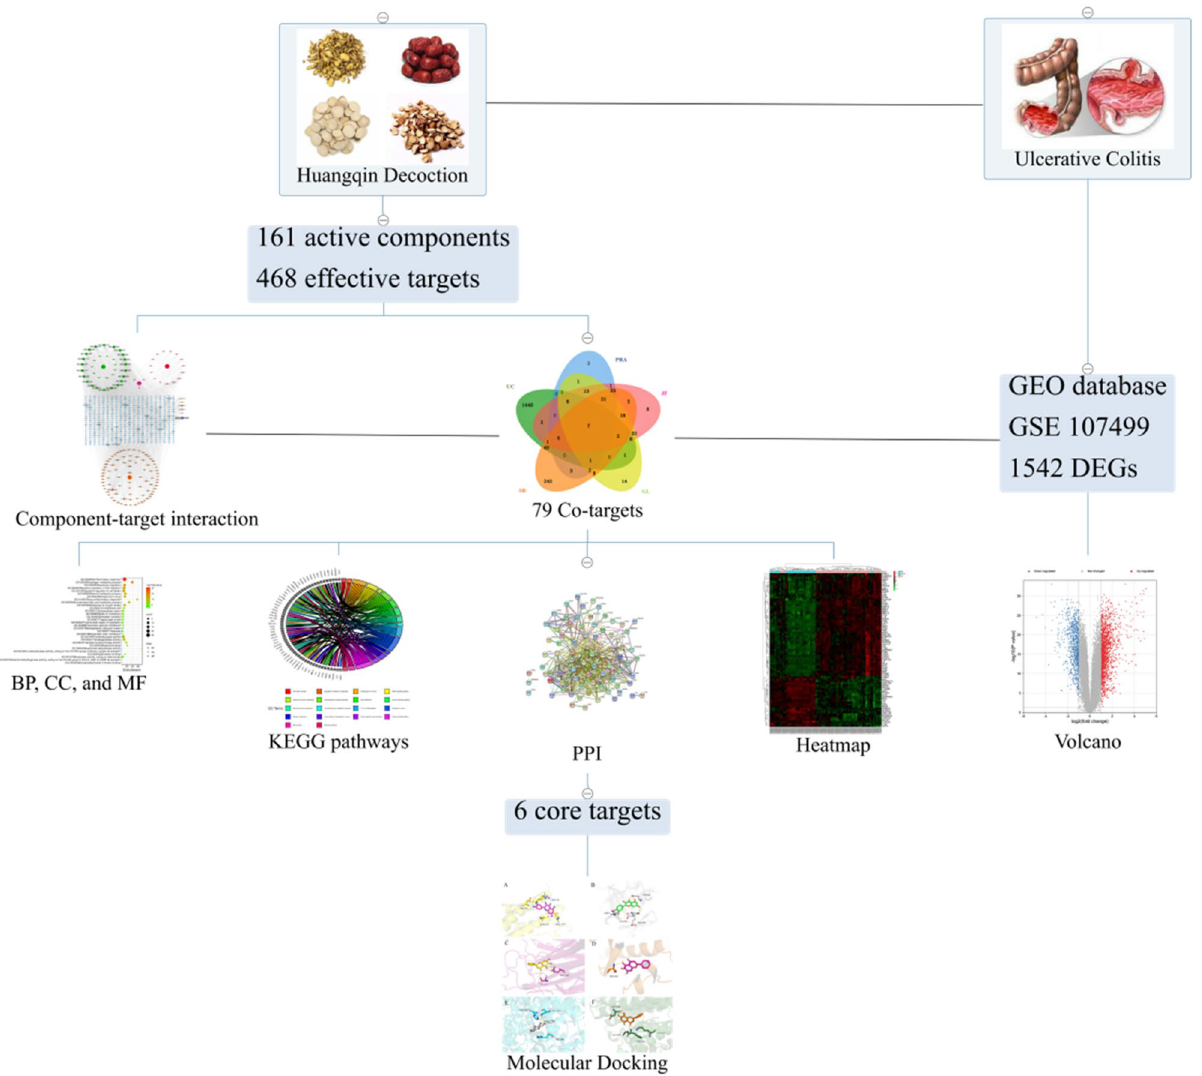
Figure 1. Workflow diagram of the network pharmacology combined bioinformatics analysis of HQD in the treatment of ulcerative